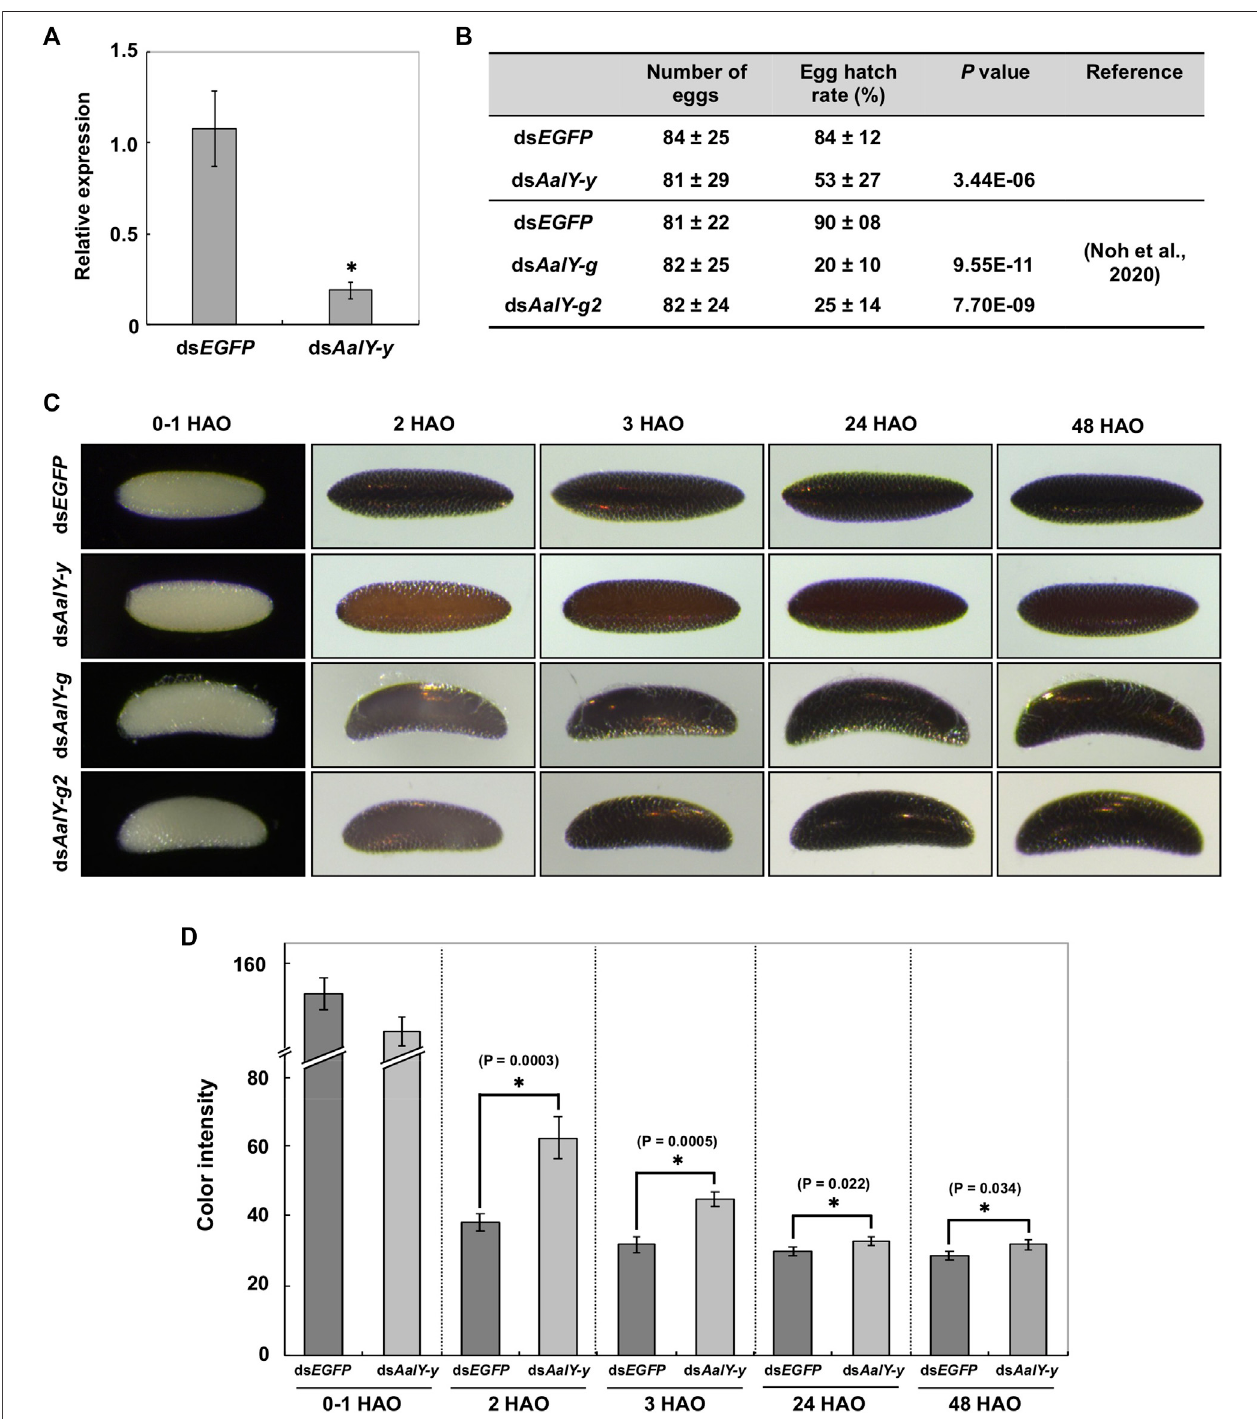
FIGURE 3 | Loss-of-function egg phenotypes produced by RNAi of AalY-y . ds AalY-y or ds EGFP (1 μ gper insect) wasinjected into 3 day-old adult females shortly after blood-feeding. (A) Total RNA was isolated from adults (n (cid:1) 5) 48 h after dsRNA treatment to analyze knockdown levels of AalY-y transcripts. Expression levels of AalY-y inds AalY-y -treatedinsectsarepresentedrelativetotheirlevelsinds EGFP -treatedcontrol.Anasteriskindicatesasigni fi cantdifferenceintranscriptlevelsof AalY-y betweencontrolandtestanimals( p (cid:1) 0.01, t -test).Dataareshownasthemeanvalue ± SE(n (cid:1) 3). (B) Injectionofds AalY-y hadnosigni fi canteffectonfecundity( p > 0.36, t -test), while itdecreased egghatching rate by nearly a half( p < 3.44E-06, t -test). Dataare shown asthe mean value ± SE(n (cid:1) 17 – 27). However, as seenfollowing RNAi of AalY-g and AalY-g2 (Noh et al., 2020), a signi fi cantly decreased egg hatch rate was observed in ds AalY-y -treated insects. (C) dsRNAs for AalY-g and AalY-g2 | were synthesized and injected as previously reported (Noh et al., 2020). Melanization of either ds AalY-g or ds AalY-g2 eggs was delayed for 2 h after oviposition (HAO)